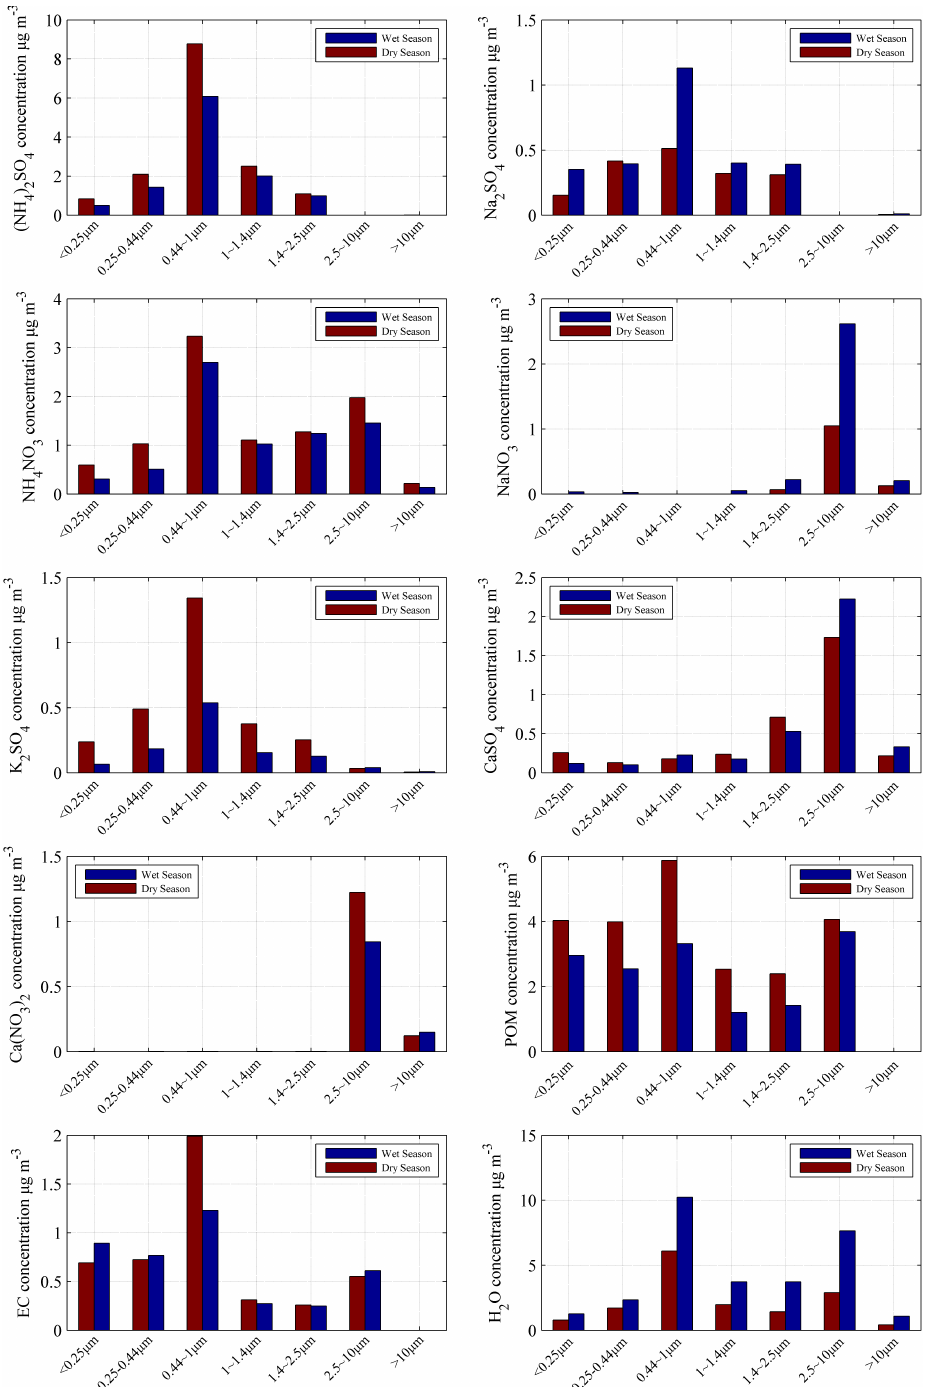
Figure 3 Mass size distributions of the reconstructed major chemical constituents Figure 3. Mass size distributions of the reconstructed major chemical constituents.